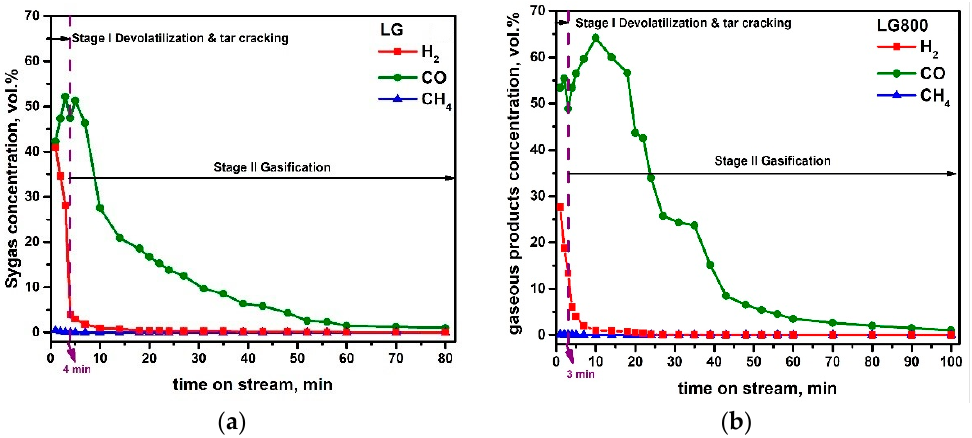
Figure 11. Syngas composition with time on stream for LG ( a ) and LG800 ( b ) CO 2 gasification at